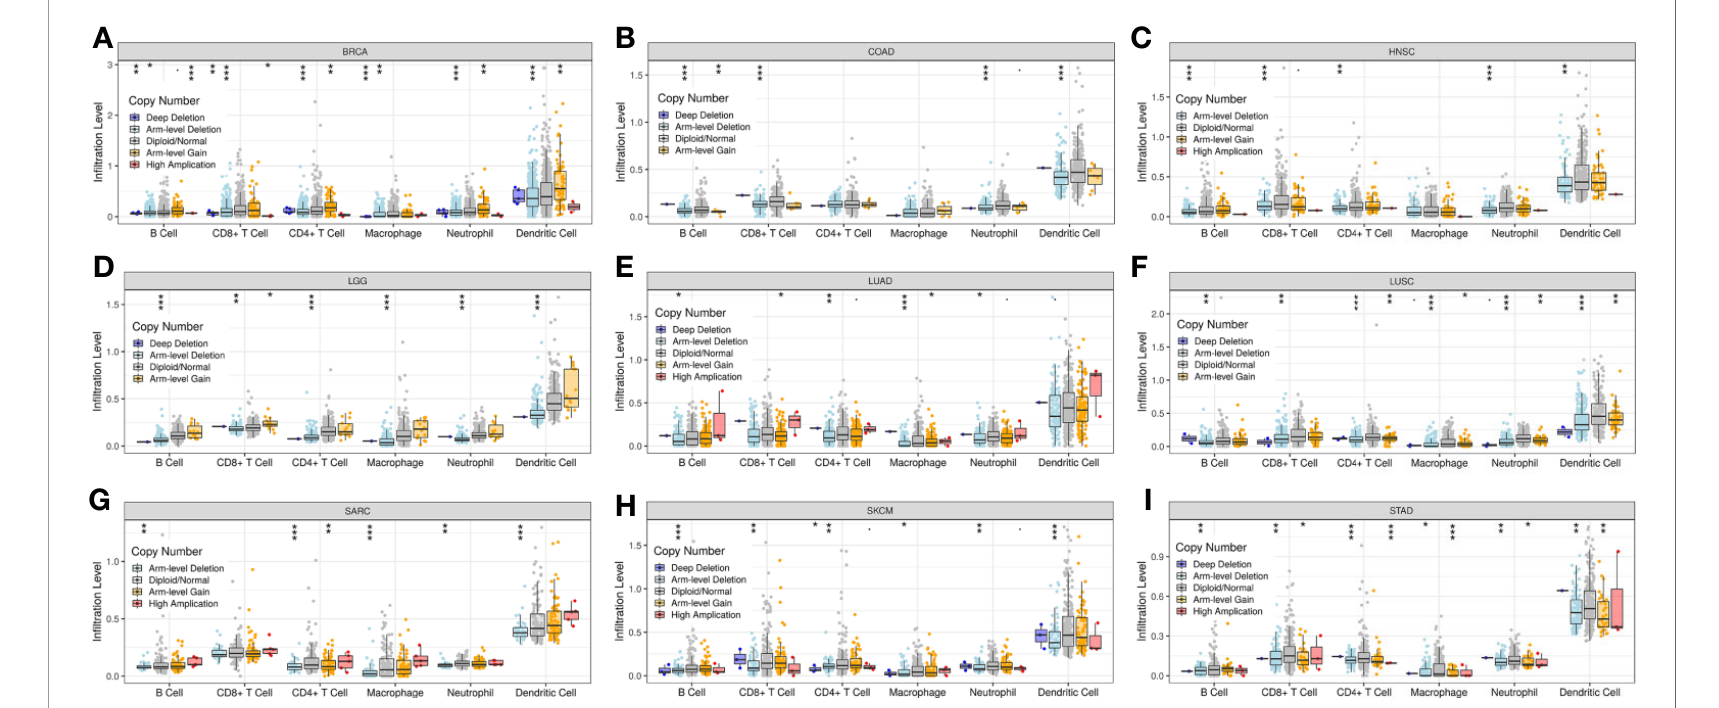
FIGURE 6 | The association between PINK1 copy number variations and immune in fi ltrates in (A) BRCA (breast invasive carcinoma), (B) COAD (colon adenocarcinoma), (C) HNSC (head and neck cancer), (D) LGG (lower grade glioma), (E) LUAD (lung adenocarcinoma), (F) LUSC (lung squamous cell carcinoma), (G) SARC (sarcoma), (H) SKCM (skin cutaneous melanoma), (I) STAD (stomach adenocarcinoma). *P < 0.05, **P < 0.01, ***P <